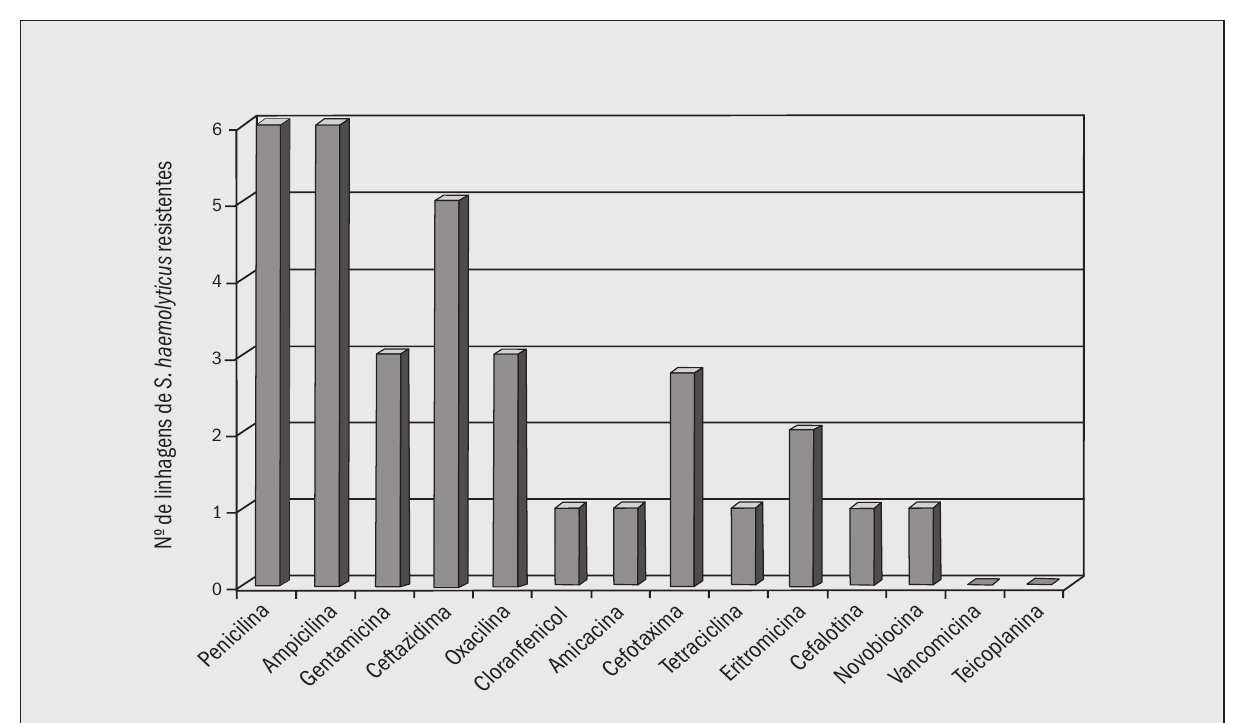
Figura 3 – Resistência às drogas apresentada pelas linhagens de S. epidermidis